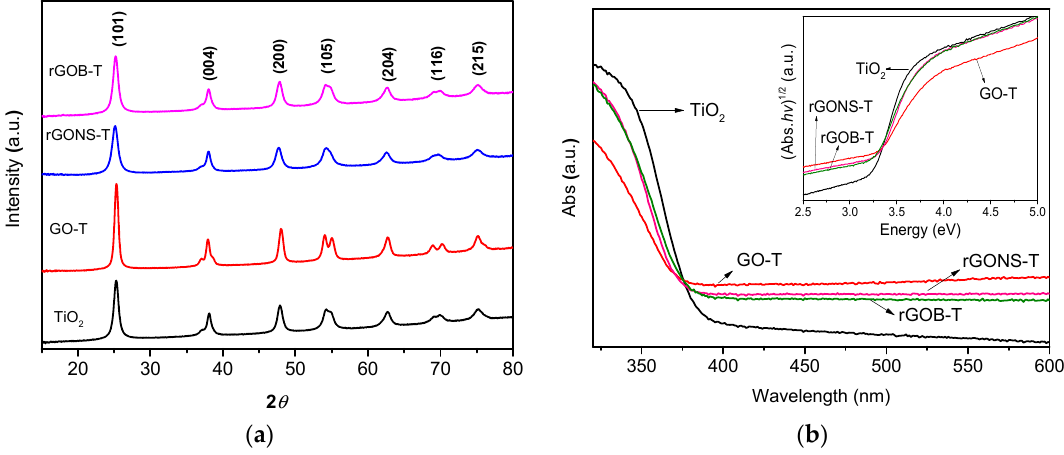
Figure 4. ( a ) XRD patterns of TiO 2 , GO-T, rGONS-T, and rGOB-T, ( b ) UV–Vis spectra and Tauc’s plots versus the energy in eV of TiO 2 and graphene derivative-TiO 2 composites (inset).